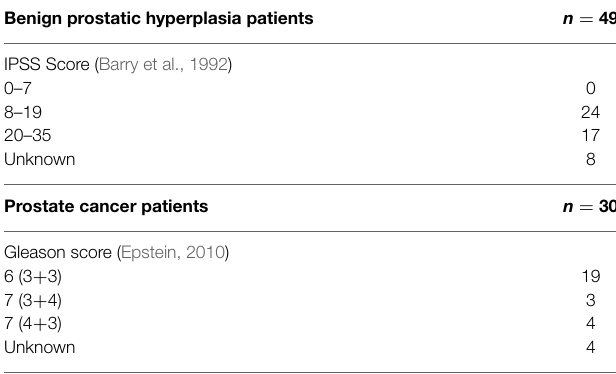
TABLE 1 | Disease scores of the patients.